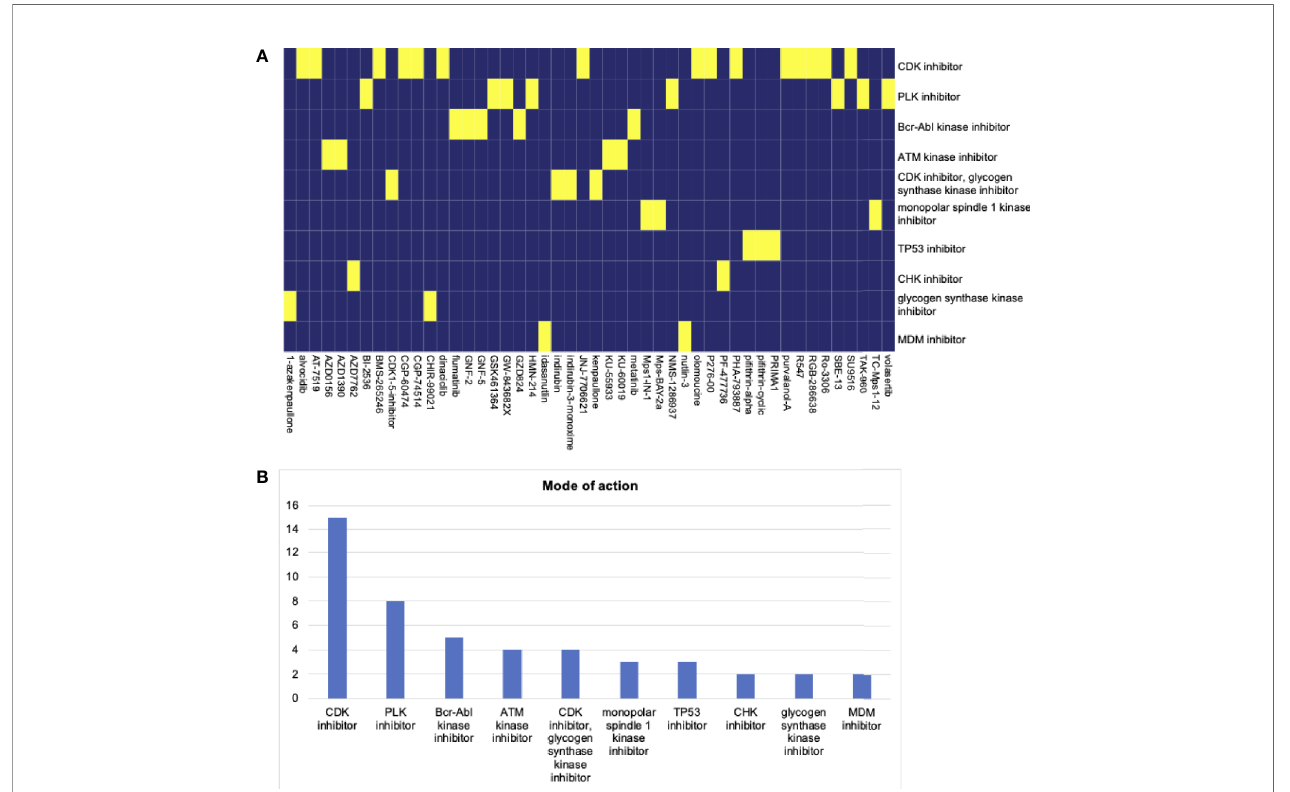
FIGURE 6 | (A) The heatmap of compounds from the CMap that share mechanism of action based on co-expression genes. (B) The number of genes enriched in each mechanism of action. The top hit is the CDK